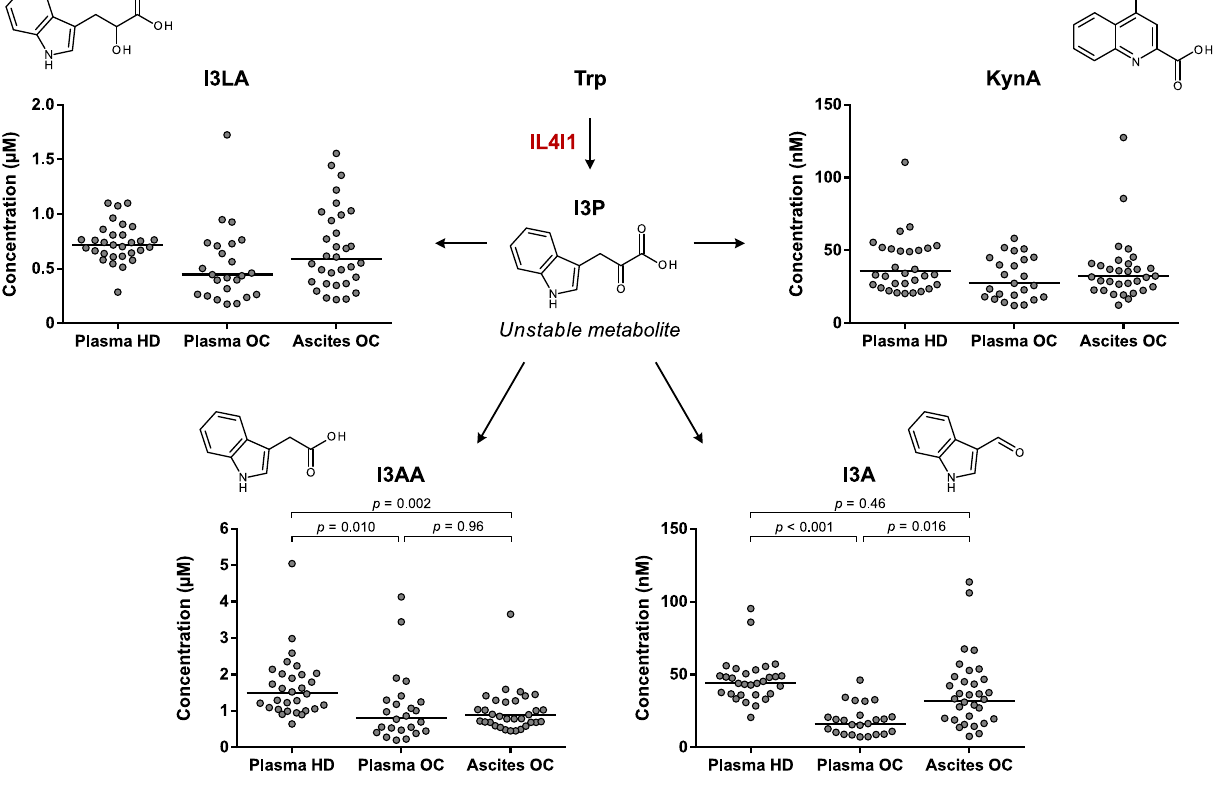
Figure 5. Trp metabolism towards I3P formation in high-grade serous ovarian cancer patients and healthy donors. Levels of Trp downstream metabolites are shown as surrogate measures of Trp-metabolizing IL4I1 activity in plasma of healthy donors (HD) ( n = 30) and plasma and ascites of ovarian cancer patients (OC) ( n = 24 and 32, respectively, with n = 22 overlapping patients). Horizontal lines indicate geometric means. Repeated unpaired, two-tailed Kruskal–Wallis tests yielded significant results for comparison of I3AA ( p = 0.002) and I3A ( p < 0.001)—but not I3LA and KynA—levels between the groups. Results of Dunn’s post hoc tests are indicated in the graphs where applicable. I3A: indole-3-aldehyde; I3AA: indole-3-acetic acid; I3LA: indole-3-lactic acid; I3P: indole-3-pyruvic acid; IL4I1: interleukin 4 induced 1; KynA: kynurenic acid; Trp: L